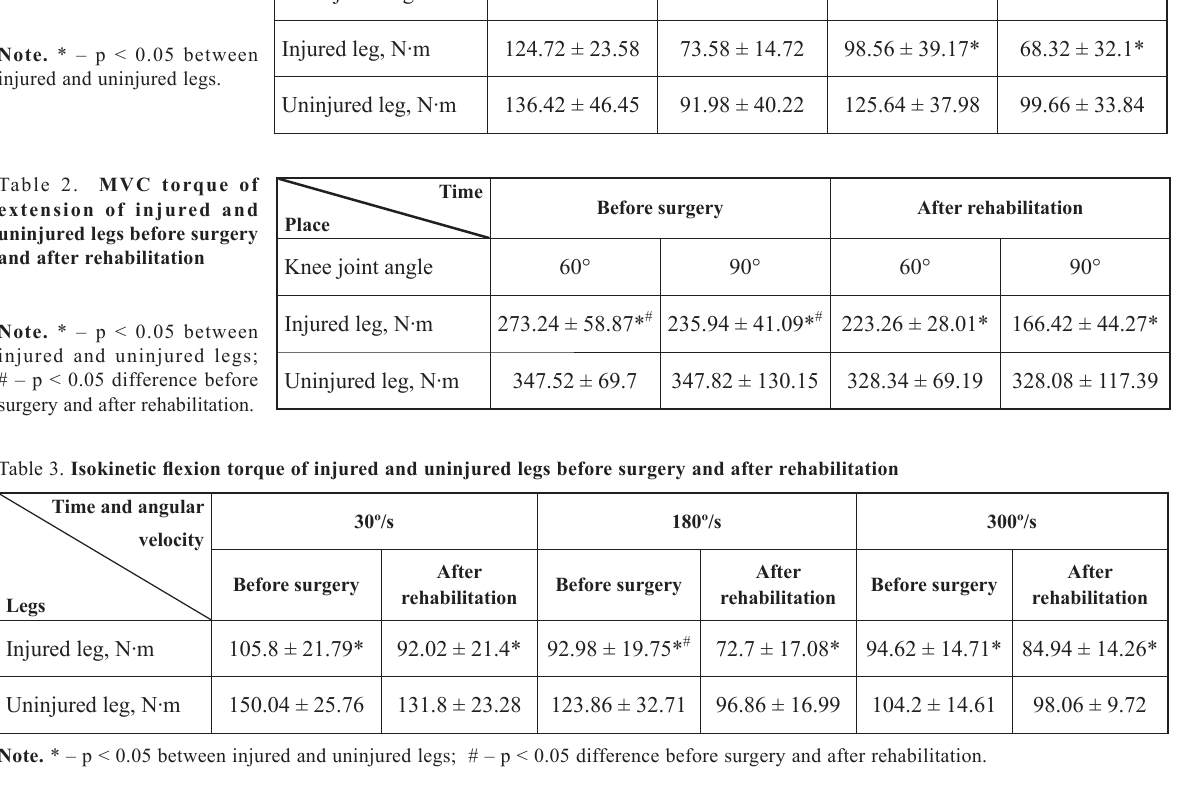
Table 4. Isokinetic extension torque of injured and uninjured legs before surgery and after rehabilitation